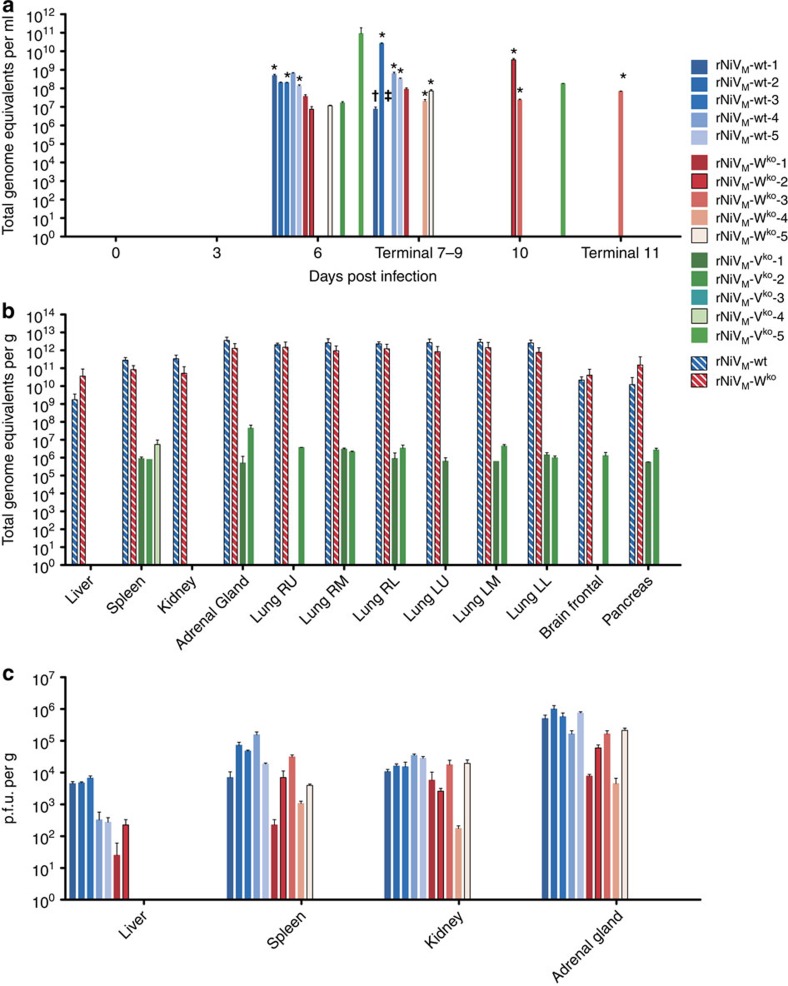
Viral load in rNiVM-infected ferrets.Viral load in ferrets as detected by GEq using qRT–PCR from (a) whole blood as GEq per ml and from (b) tissues as GEq per g (c) p.f.u. per g of rNiVM isolated from tissues of ferrets after necropsy. Hashed blue and red lines represent the average of all animals in the rNiVM-wt and rNiVM-Wko cohorts, respectively. Error bars show s.d. N=5 for hashed lines; N=2 for all other lines. Right upper (R.U.), right middle (R.M.), right lower (R.L.), left upper (L.U.), left middle (L.M.), left upper (L.U.) *indicates samples in which rNiVM was successfully isolated from whole-blood samples. †Animal was found dead, blood was examined using qRT–PCR but no attempt was made to isolate virus. ‡Animal was found dead and no attempt was made to examine blood using qPCR or to isolate virus.